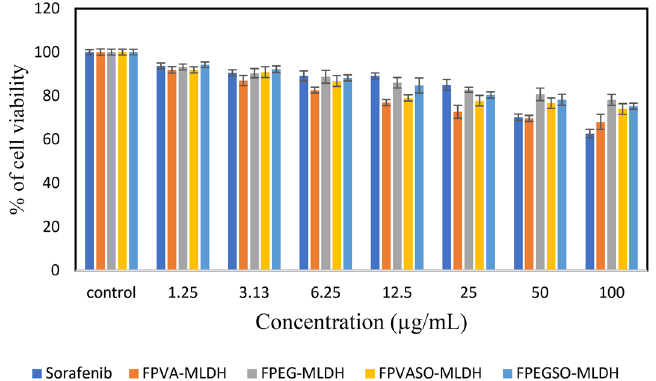
Figure 13. Cytotoxicity assay of Sorafenib (SO), FPEG-MLDH, FPVA-MLDH, FPEGSO-MLDH and FPVASO-MLDH against normal 3T3 cells at 72 h. Results were calculated as mean ± standard deviation for